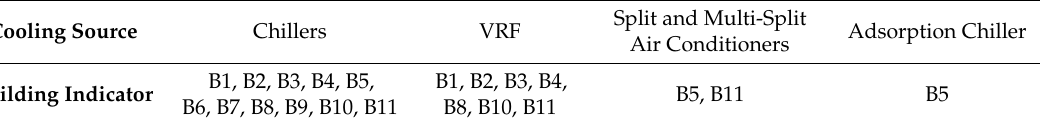
Table 8. Cooling sources in buildings.